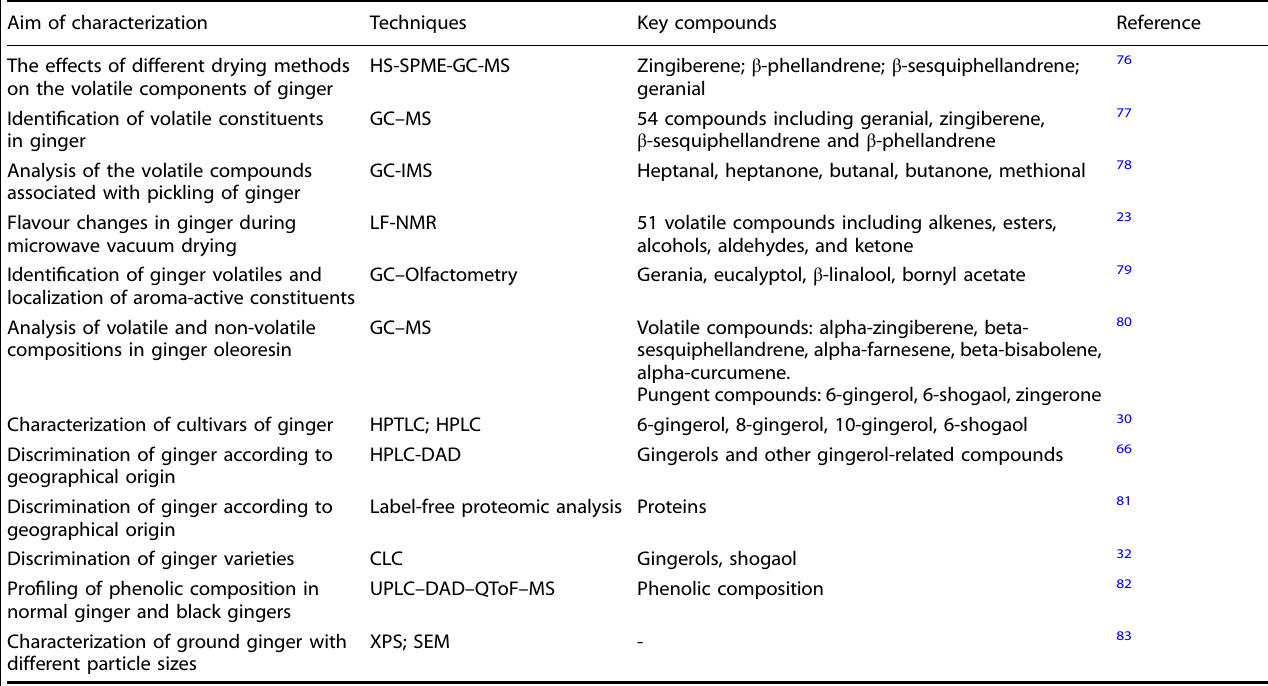
Table 8. Analytical techniques used for ginger